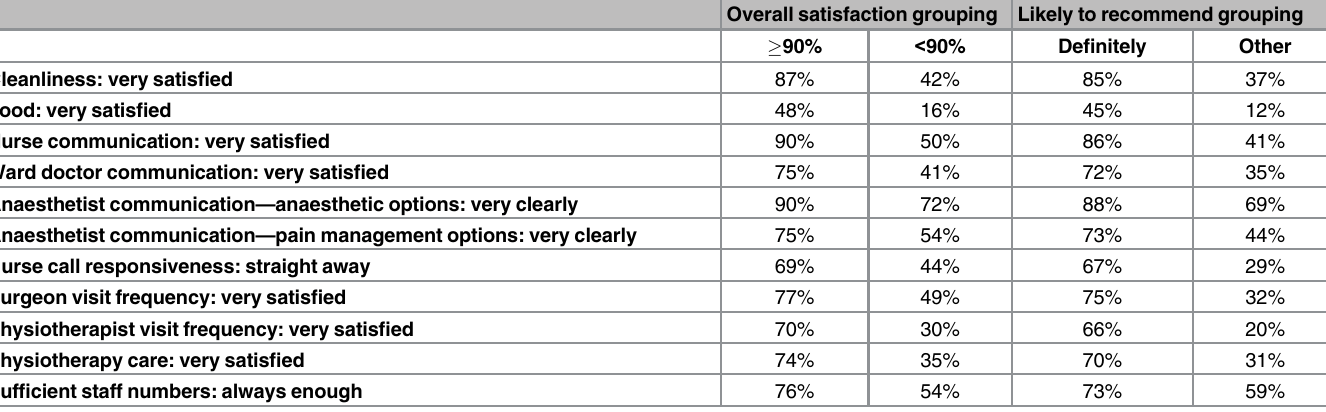
Table 7. Proportion of respondents in the ‘ Overall satisfaction ’ group ( (cid:1) 90%, < 90%) and ‘ Likely to recommend ’ group (Definitely or Other) report- ing the top response in each service domain. Overall satisfaction grouping Likely to recommend